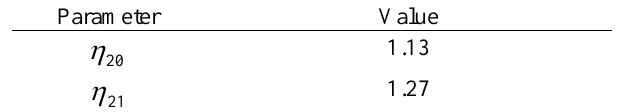
Design Parameters compensator based